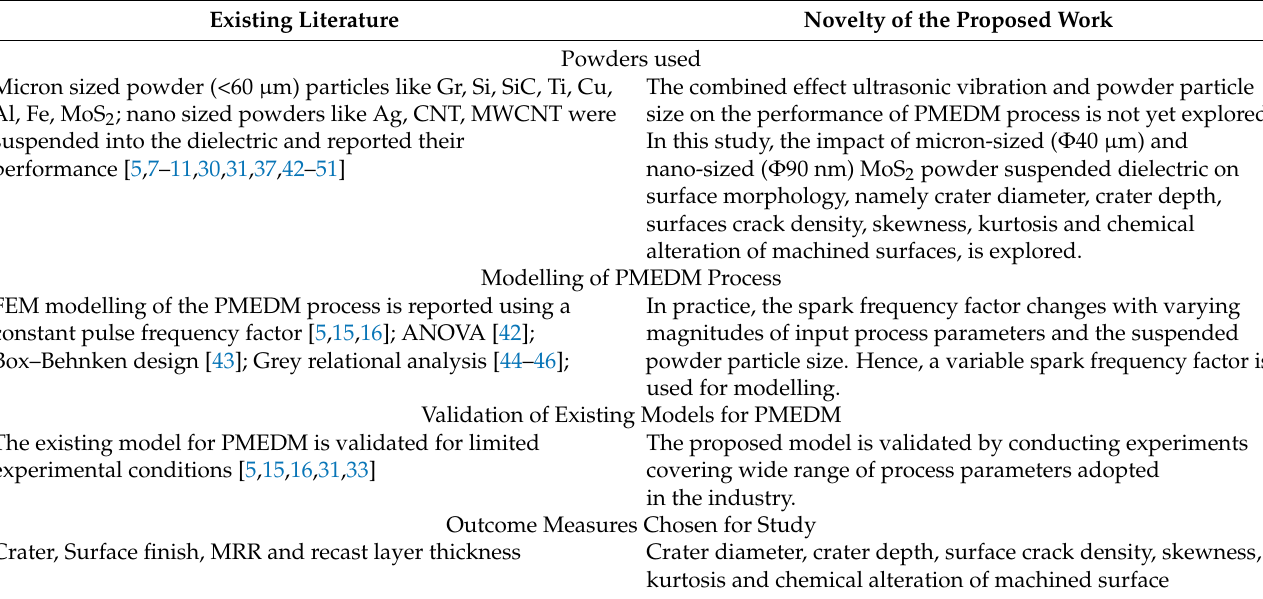
Table 1. Comparison on existing literature and contribution of proposed work in PMEDM